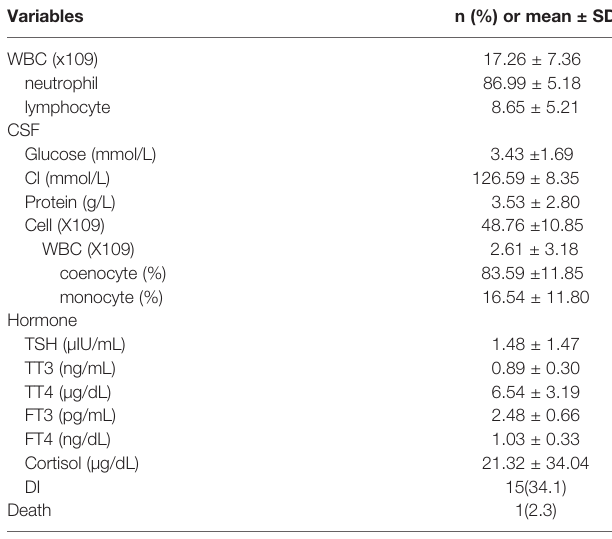
TABLE 2 | Characteristics of PCNSI patients.